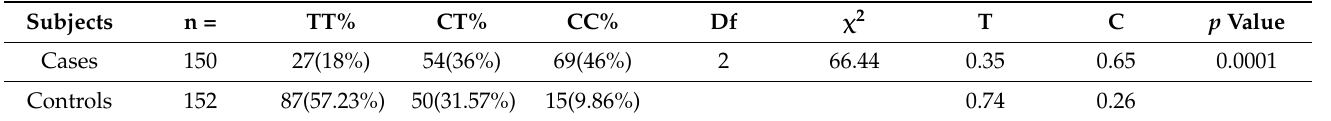
Table 6. Statistical comparisons between CAD patients’ ACE2 rs4240157T>C